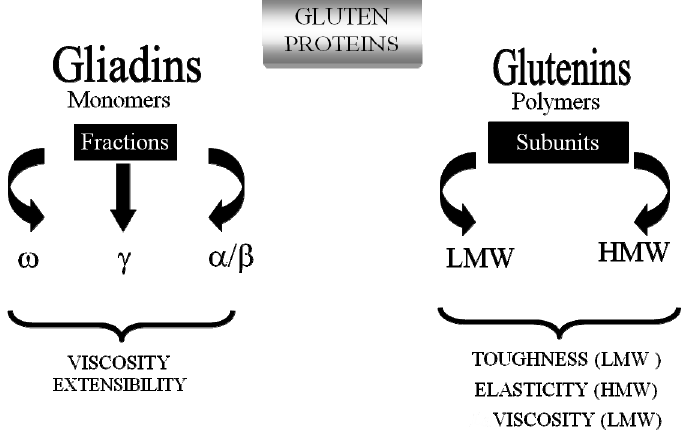
Figure 2. Gluten proteins: fractions and technological properties